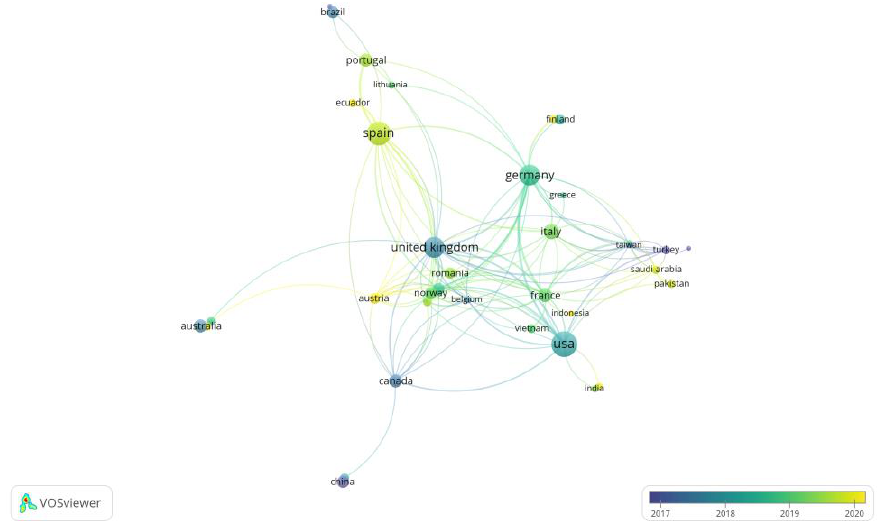
Figure 4. Country contributions per article over time showing n = 39 countries within the densest co-authored papers network. Node size indicates the total link strength, the edges show co-authored papers. Source: VOSViewer.